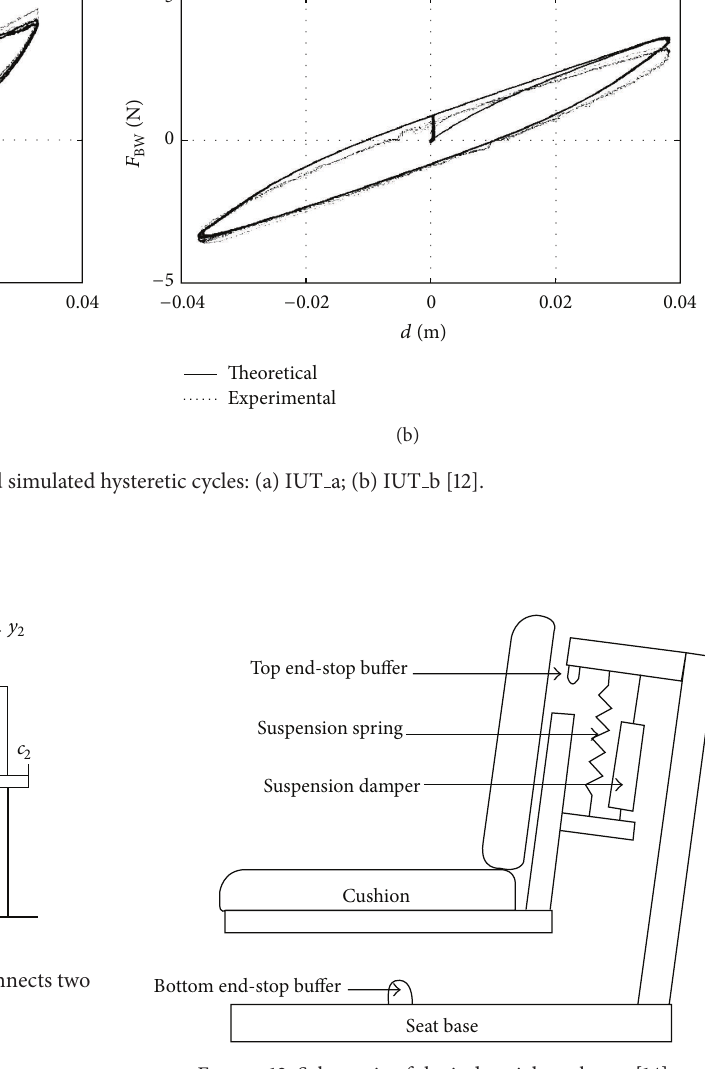
Figure 12: Schematic of the industrial truck seat